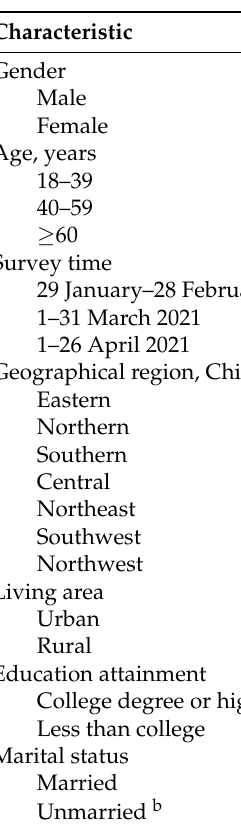
Table 1. Sociodemographic characteristics of the total sample ( n =